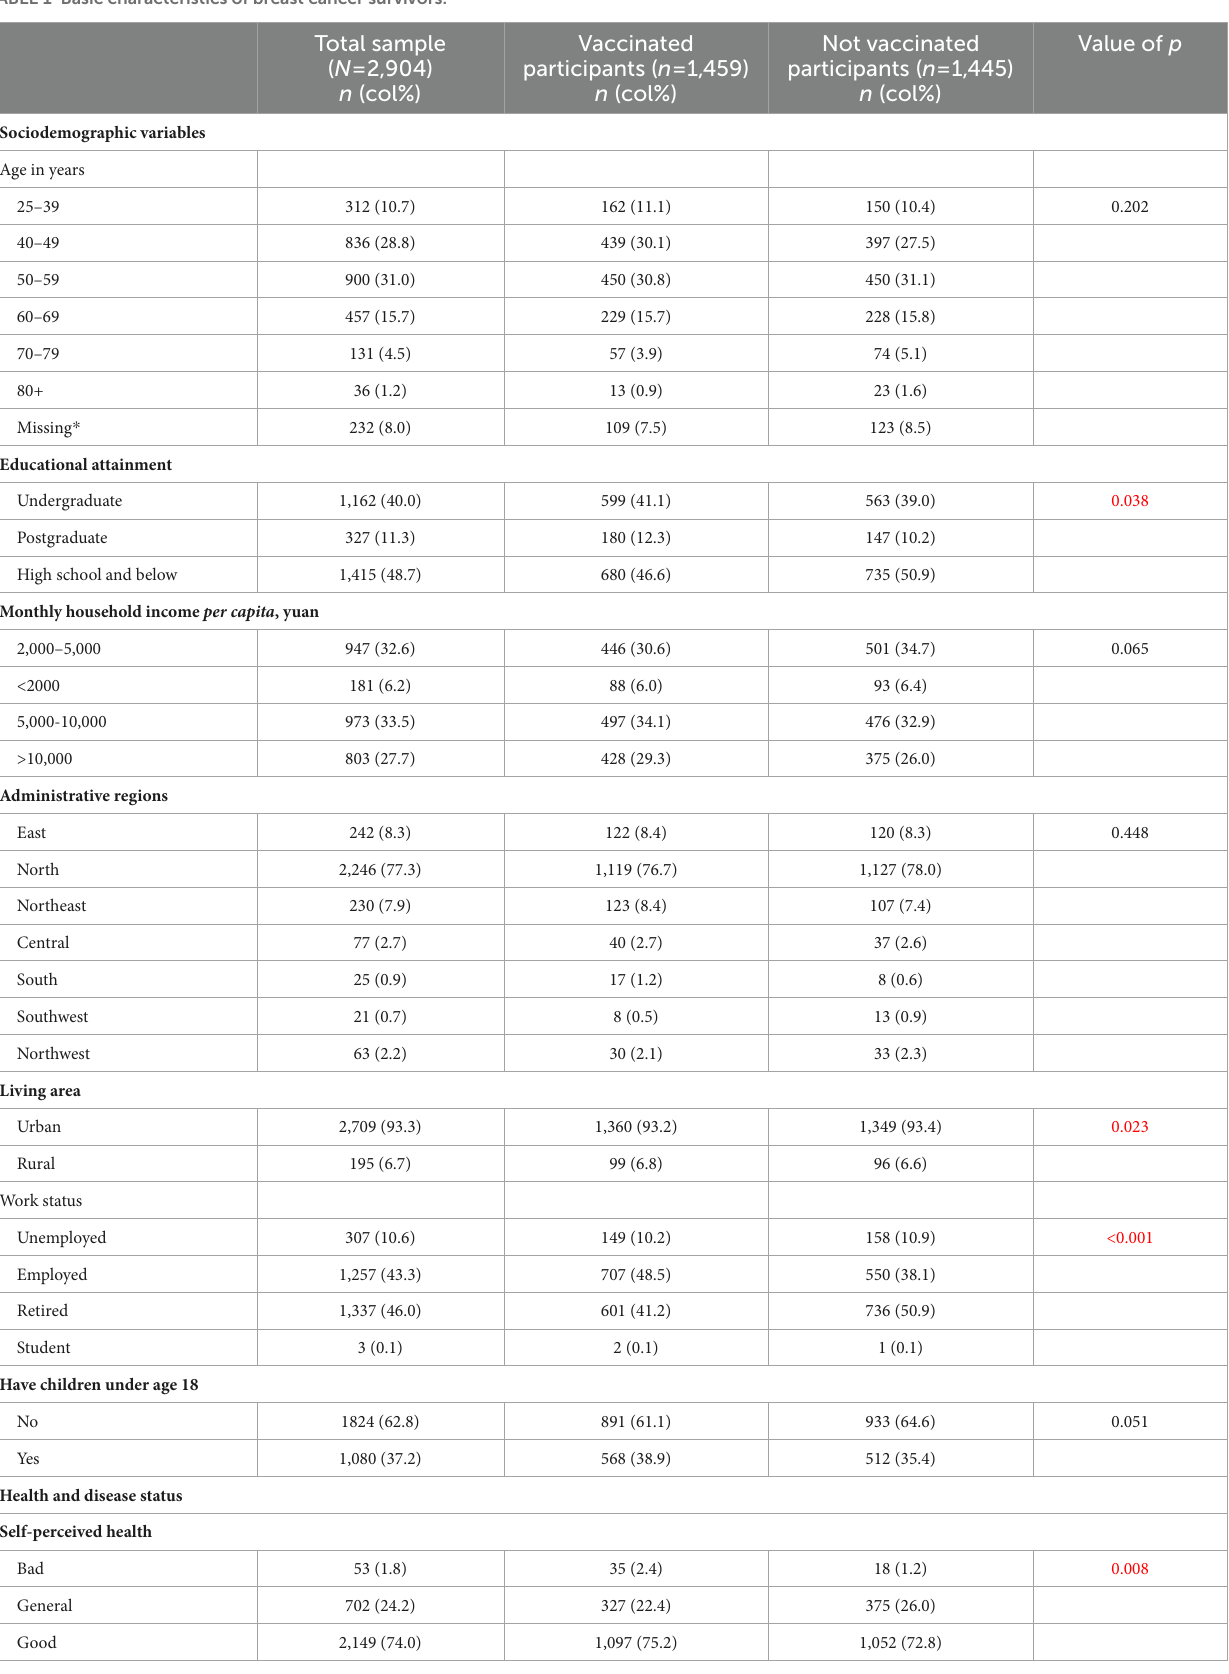
TABLE 1 Basic characteristics of breast cancer